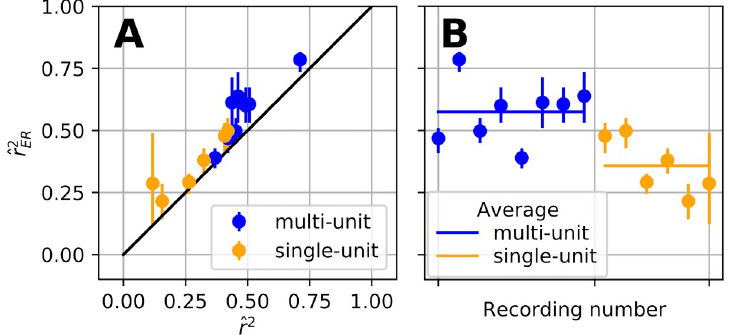
Fig 10. Applying ^ r 2 to analyze performance of a deep neural network (DNN) in predicting V4 responses to ER natural images. (A) For single-unit (orange) and multi-unit (blue) recordings, ^ r 2 relatively short α = 0.1 CIs (vertical bars) suggest that most of these correlation values are trustworthy. (B) The mean ^ r 2 value across multi-unit recordings (horizontal blue line) is significantly higher than that for the set of single-unit ER recordings (orange horizontal line; Welch’s t-test t = 3.7, p = 0.005). Because individual estimates are asymptotically unbiased, the group average inherits this lack of